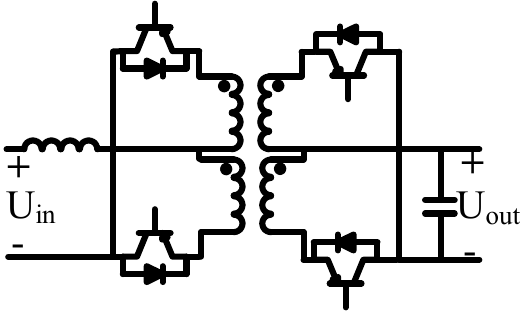
Figure 11. Topology of isolated half-bridge bi-directional DC/DC converter. Isolated push–pull bidirectional DC/DC converters are relatively simple in structure. Still, because of the large switching voltage spikes caused by transformer leakage, the switching tubes operate under harsh conditions and are suitable for low- and medium- voltage applications. The topology of the isolated push–pull bidirectional DC/DC converter is shown in Figure 12.